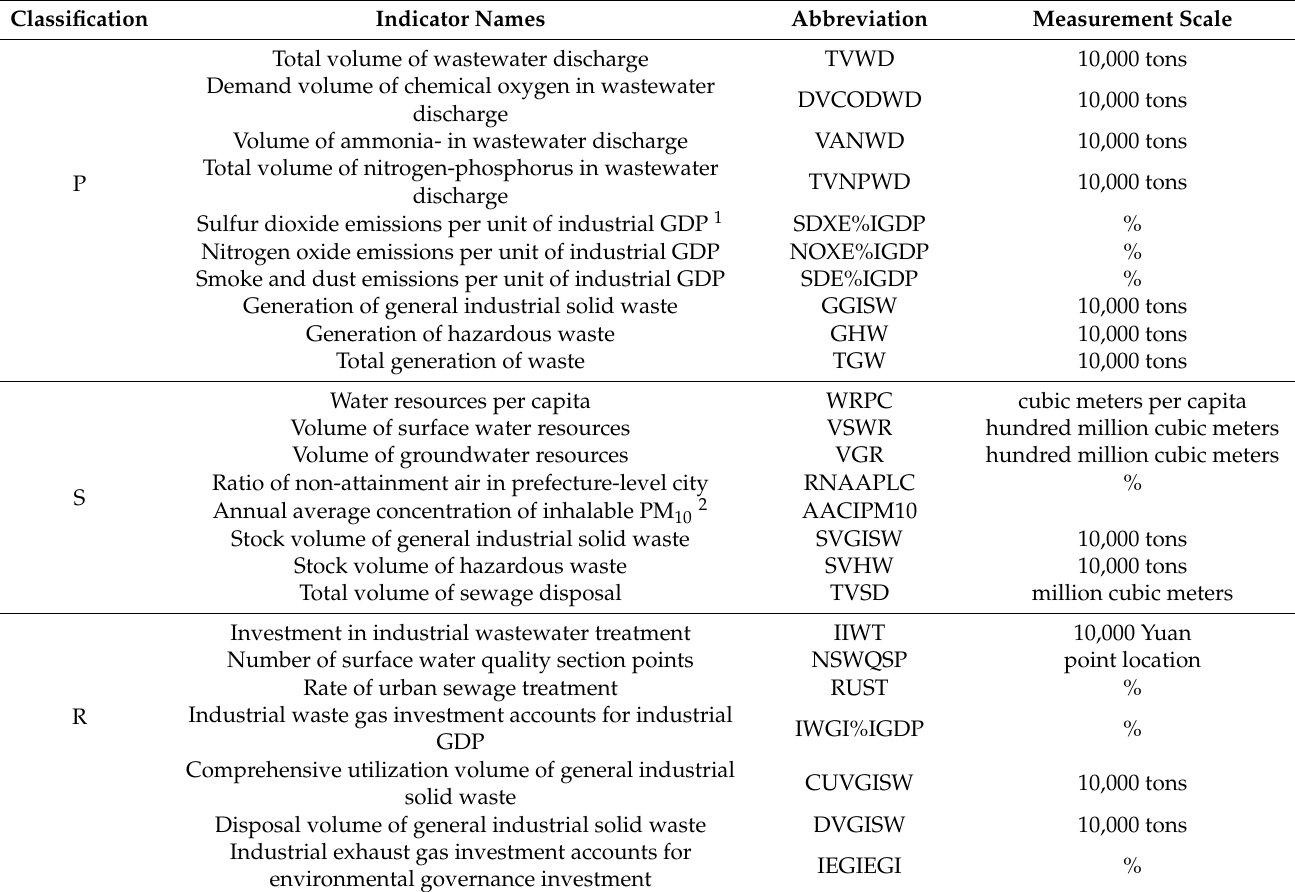
Table 1. Variable Descriptions and Measurement